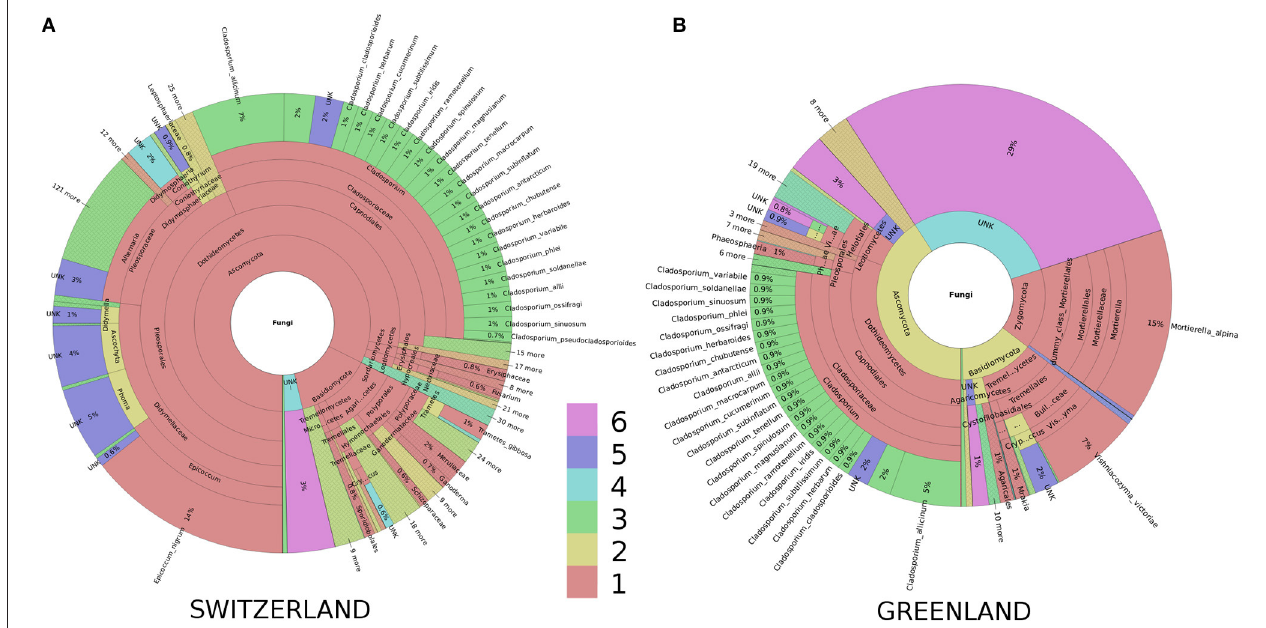
FIGURE 4 | Krona-wheels illustrating taxonomic distributions in the samples. Shown are the results for pooled samples from Switzerland (A) and pooled samples from Greenland (B) . Similar Krona-wheels for all five sampling locations (that can be interactively explored by the user e.g., to zoom to certain taxa) are given in Supplementary Information . The colors show the type and confidence level of each taxonomical placement. Colors 1–3 correspond to well-identified taxonomic units for which the proportion of reliable identifications is in the range [50%...100%] (Color 1), (0%...50%) (Color 2), or 0% (Color 3). Colors 4–6 correspond to unknown taxonomic units for which the proportion of reliable identifications is in the range [50%...100%] (Color 4), (0%...50%) (Color 5), or 0% (Color